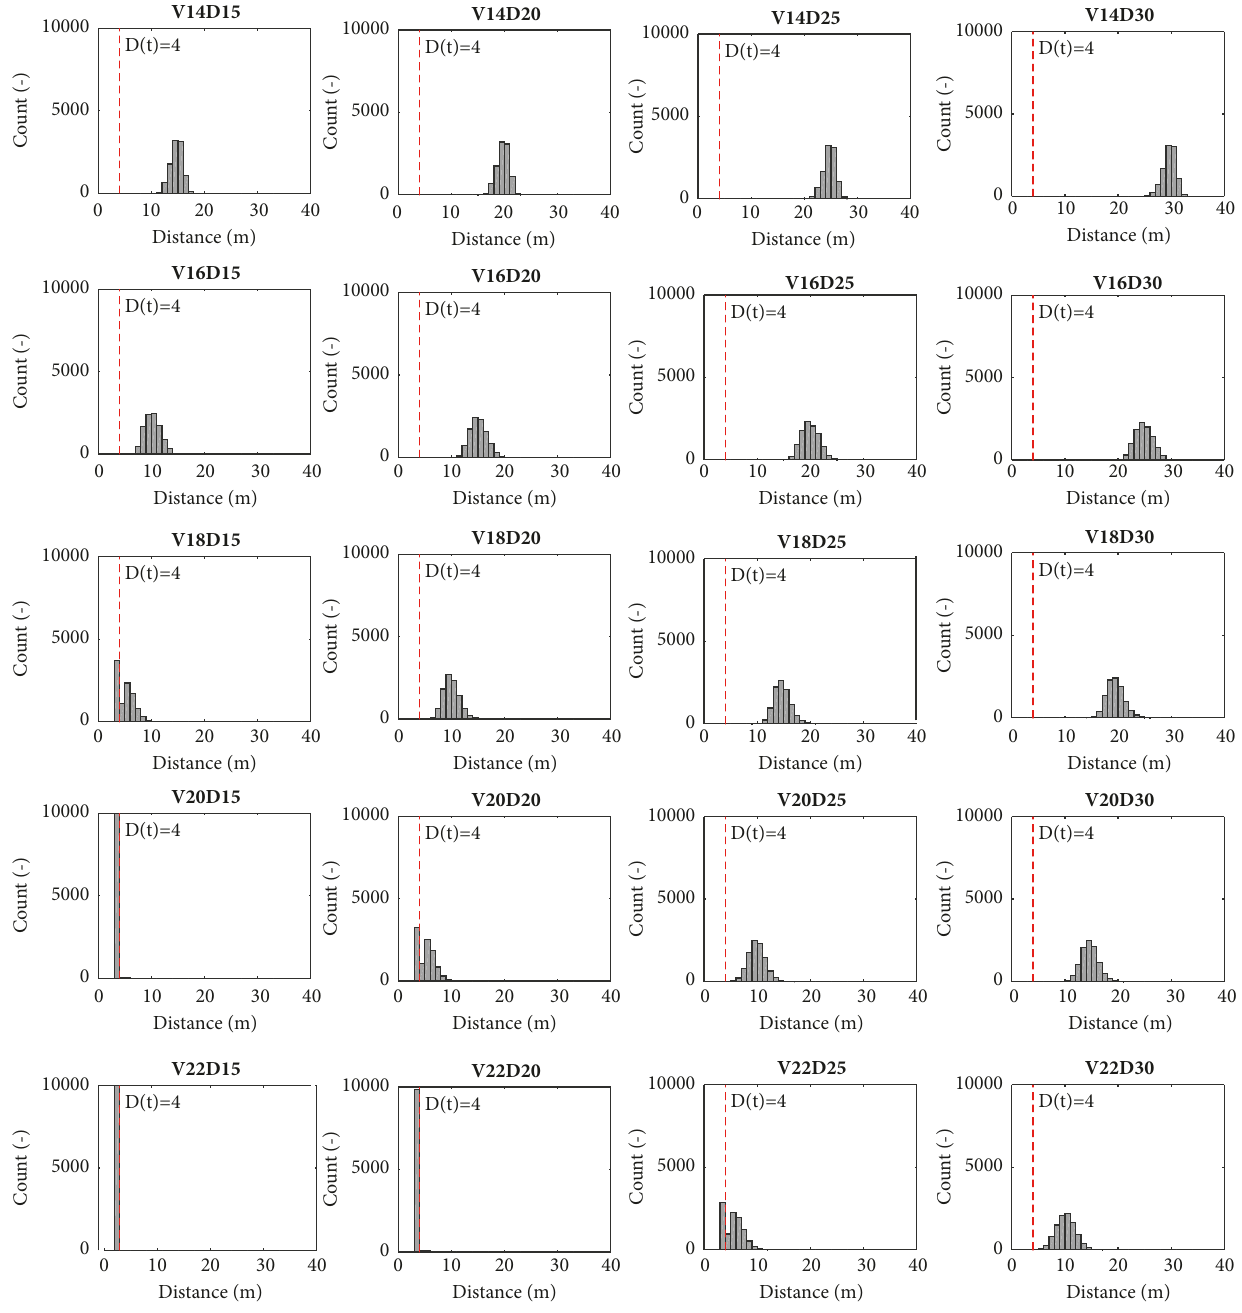
Figure 11: The probability of rear-end collisions under five levels of speed and four levels of distance conditions (V represents driving speed and D represents headway distance; e.g., V14D15 means the driving speed is 14 m/s and headway distance is 15 m).